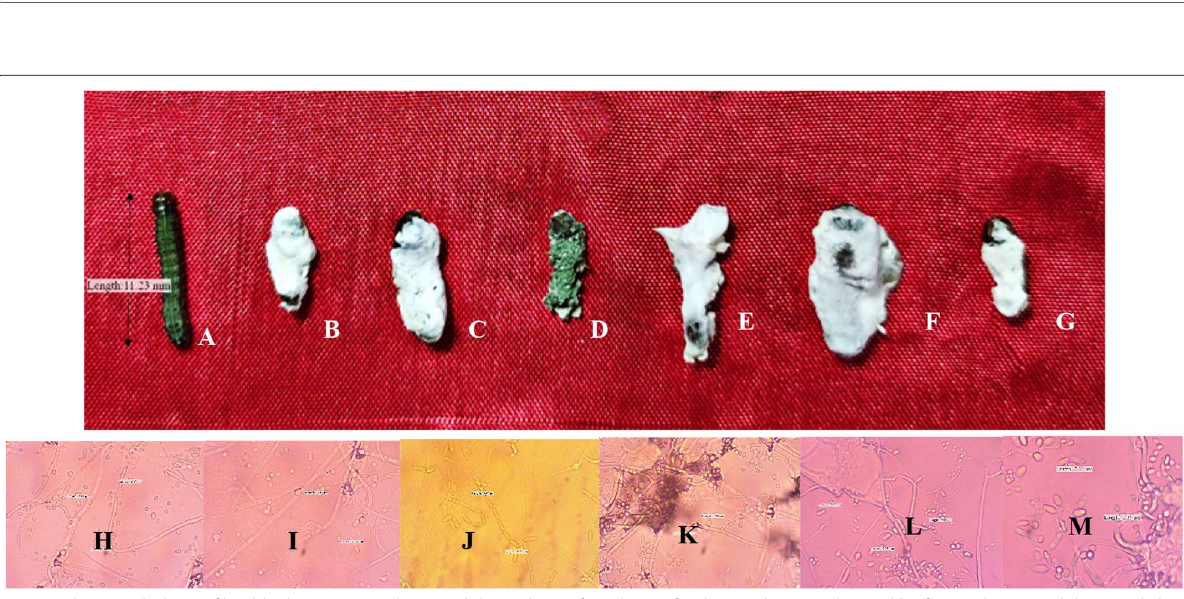
Fig. 4 The morphology of healthy larvae (control) ( A ) and the cadavers from larvae feeding on leaves colonized by fungi (above) and the conidial and hyphal morphology of fungi from cadaver re-isolation (below): Beauveria bassiana of JGTP240521 isolate ( B and H ) and WTTJC260521A isolate ( C and I ), Metarhizium anisopliae WTTJC260521B isolate ( D and J ), Beauveria bassiana of WTTJC290521A isolate ( E and K ), WTTJC290521B isolate ( F and L ), and JGNT300521 isolate ( G and M